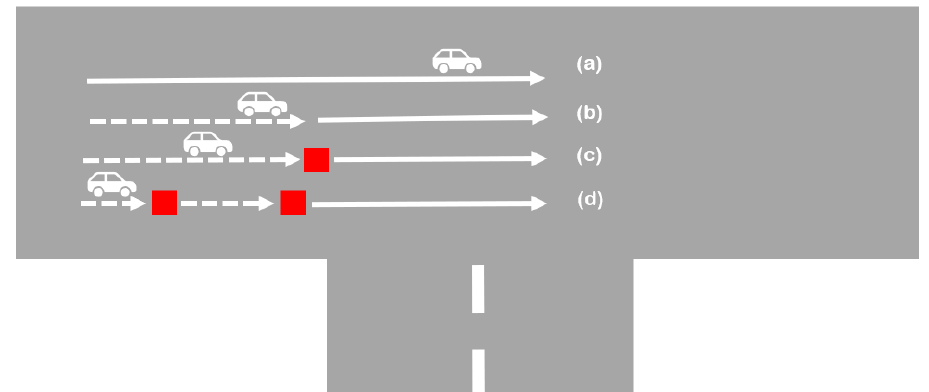
Figure 6. The four movement patterns that describe a vehicle’s crossing of a junction: ( a ) unhindered crossing, ( b ) deceleration (dotted line) without stopping, ( c ) stop once (red dot), and ( d ) stop more than once (here two stop events are depicted with the two red